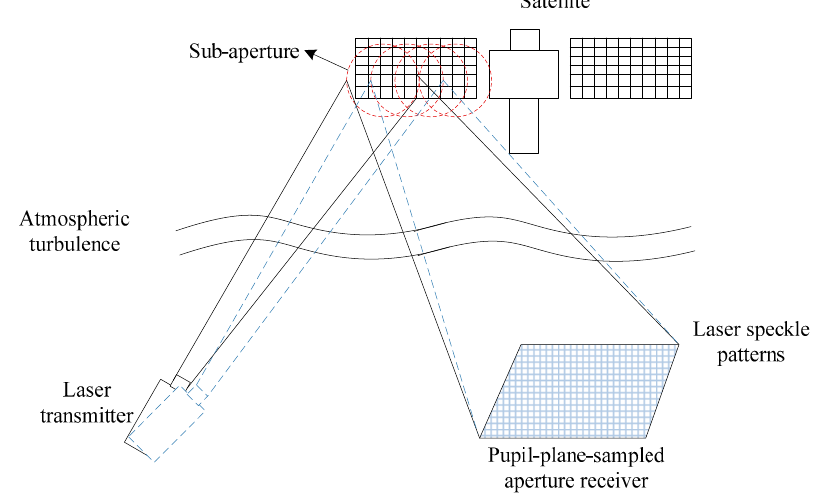
Figure 1. Schematic diagram of the ptychographic imaging correlography technique.